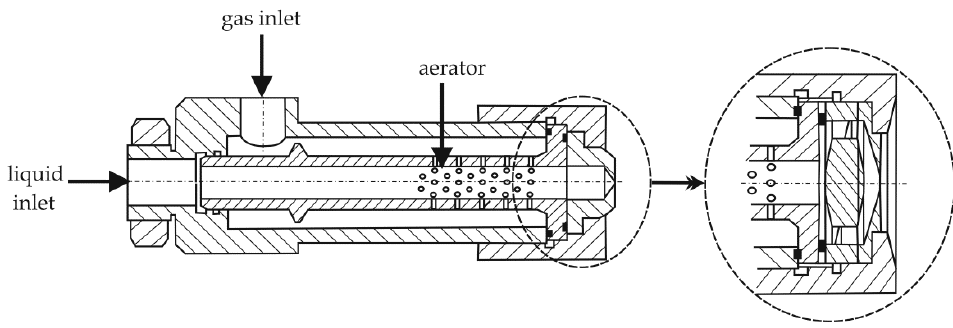
Figure 14. Diagram of the effervescent-swirl atomizer from the study [118,119]. Table 2. Summary of dimensions of individual components of atomizers [ 118 ].